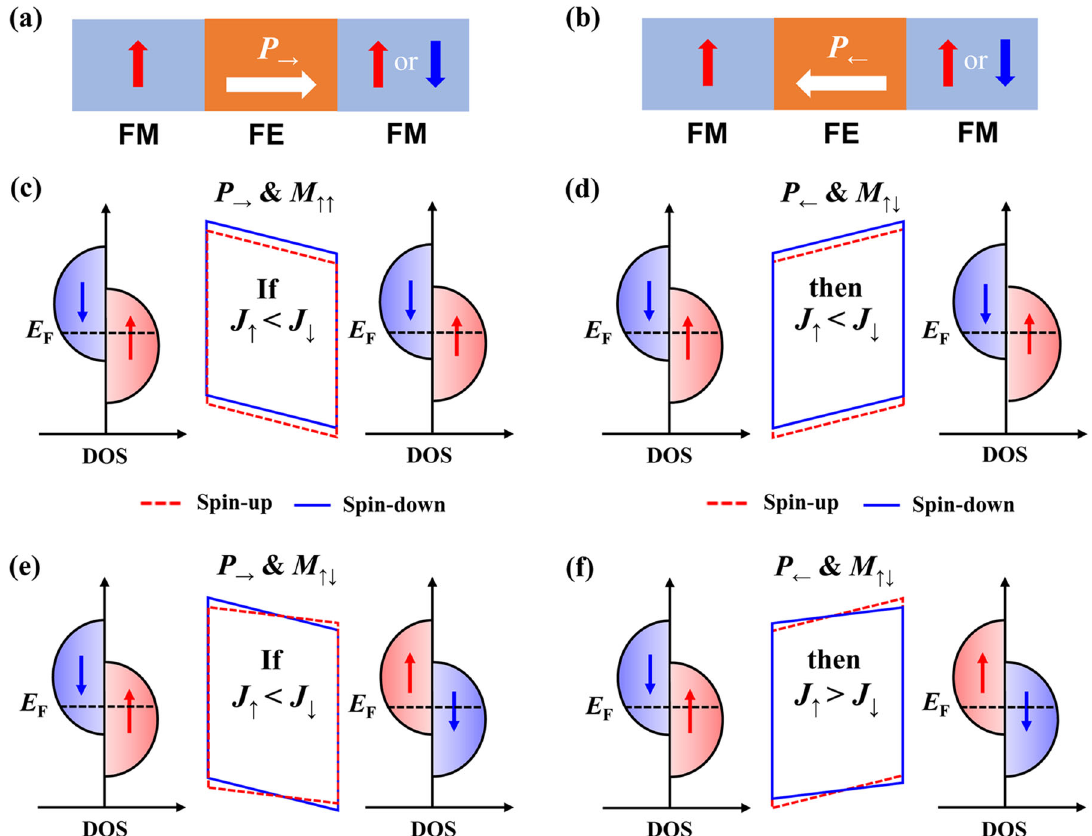
Fig. 1 The schematic mechanism for generating and switching spin-polarized current in MFTJs. Device structures of MFTJs with a ferroelectric (FE) layer sandwiched between two ferromagnetic (FM) leads: ( a ) right and ( b ) left FE polarization. MFTJs with symmetric interface terminations and interfacial magnetization: ( c ) P → and ( d ) P ← in a parallel magnetic state ( M ↑↑ ), ( e ) P → and ( f ) P ← in an antiparallel magnetic state ( M ↑↓ ). The spin current polarization at M ↑↑ does not change with the FE switching. If the current at P → and M ↑↓ is spin-down polarized with J ↑ < J ↓ , the spin polarization direction of the tunnel current is switched with the reversal of FE polarization: J ↑ > J ↓ at P ← and M ↑↓